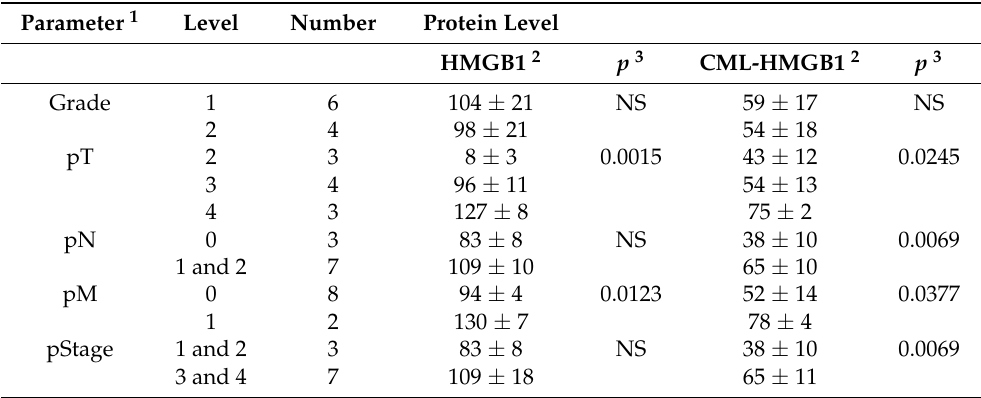
Figure 4. Formation of CML-HMGB1 in human gastric cancer. ( A ) CML-HMGB1 formation was examined by Western blot analysis in 10 human gastric cancer tumor tissues. ( B ) Comparison of HMGB1 and CML-HMGB1 levels with oxidative stress (4-HNE levels). The correlation was calculated using the Pearson’s correlation test. ( C ) Association between the relative levels of HMGB1 and CML-HMGB1. The correlation was calculated using the Pearson’s correlation test. ( D ) Effect of CML-HMGB1 on drug resistance in gastric cancer patients. Histological grade of therapeutic effect was determined according to Japanese Gastric Cancer Classification [32]. Grade 0, no effect; Grade 1a, very slight effect; Grade 1b, slight effect; Grade 2, considerable effect. Error bar, standard deviation calculated by ordinary analysis of variance from three independent experiments. CML, N ε -( Carboxymethyl ) lysine ; HMGB1, high-mobility group box-1;.4-HNE, 4-hydroxynonenal; SUM, summation of HMGB1 and CML-HMGB1 protein levels. * P < 0.05. Table 1. Relationship between pathological parameters and protein levels of HMGB1 or CML-HMGB1 in gastric cancer